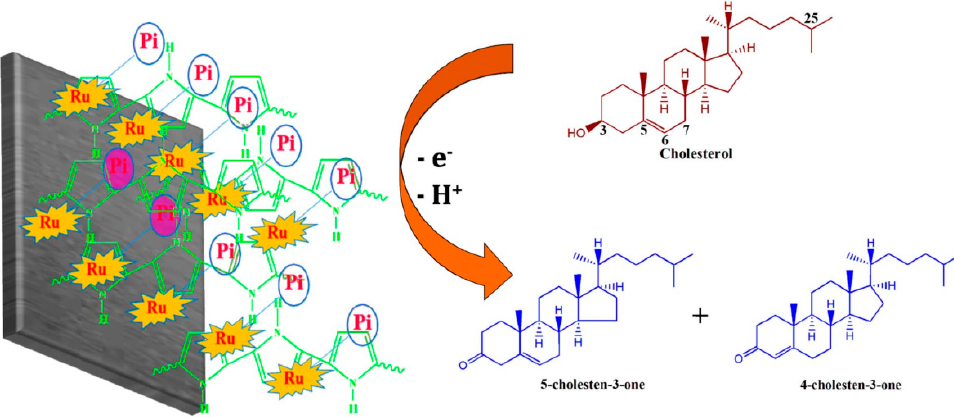
Figure 17. Schematic illustration for the probable redox mechanism of cholesterol on Ru-Pi-PPy/CFP electrode. Reprinted with permission from Ref. [100].